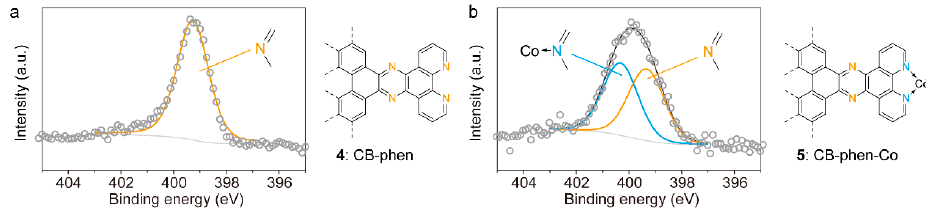
Figure 3. N 1s XPS of (a) CB-phen and (b) CB-phen-Co. Circles show the data and lines show the fitting curves.